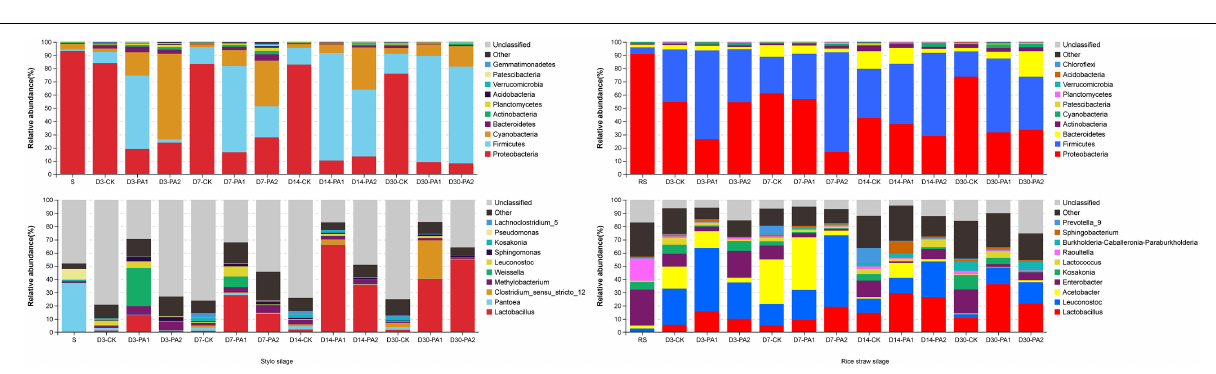
FIGURE 2 | Relative abundances of bacterial communities at the phylum and genus levels in stylo and rice straw before and after ensiling for 3, 7, 14, and 30 days with or without 1% or 2% pyroligneous